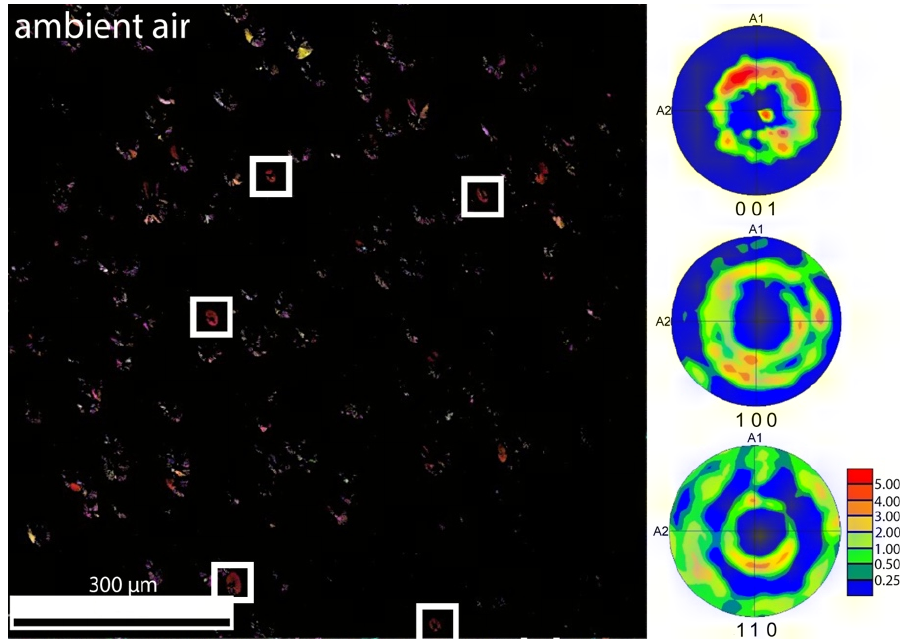
Figure 6. Texture and orientation data for a sample heat-treated in ambient air. Left: 001 inverse pole figure mapping. Right circles: pole figures 100, 001 and 110. The boxed red dots are frequently occurring circular structures.